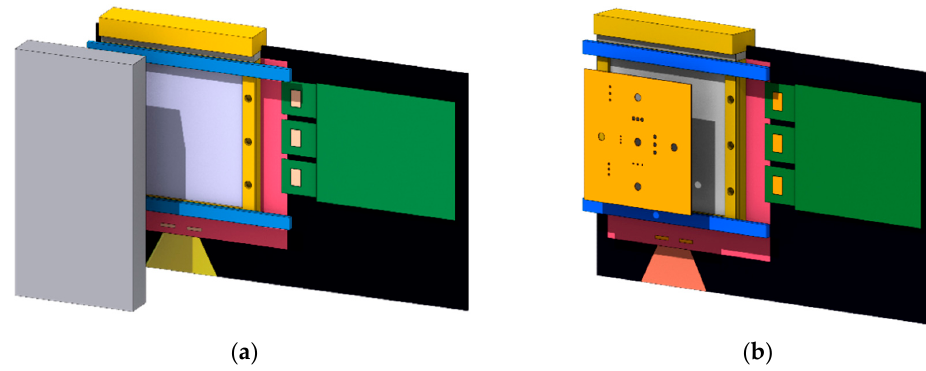
Figure 14. The simulated LaGEMPix with the 2.5 cm thick lead block in front, at 4 cm distance from the Mylar window ( a ) and a 1 mm-thick copper plate placed at 3.3 cm from the Mylar window ( b ). The figures were produced using FLAIR [56] version 3.1-8, the FLUKA graphical user-interface.